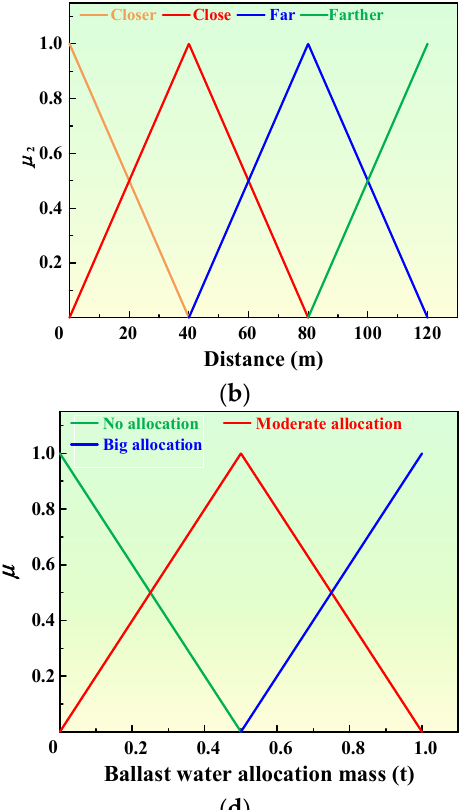
Figure 8. Membership functions of different decision variables. ( a ) The membership function of angle. ( b ) The membership function of distance. ( c ) The membership function of water level. ( d ) The membership function of allocation mass. μ means the fuzzy operator that determines the degree to which fuzzy rule antecedents are satisfied.